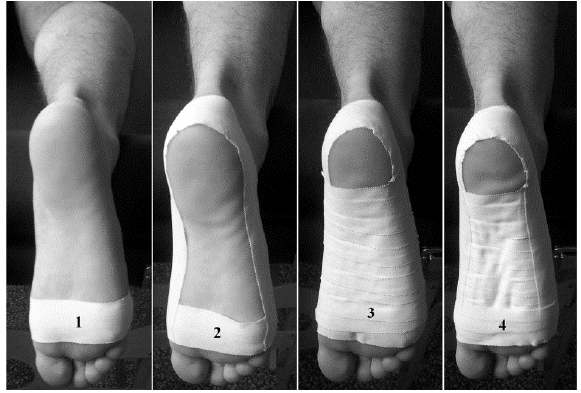
Figure 1. Low-dye taping technique. 127